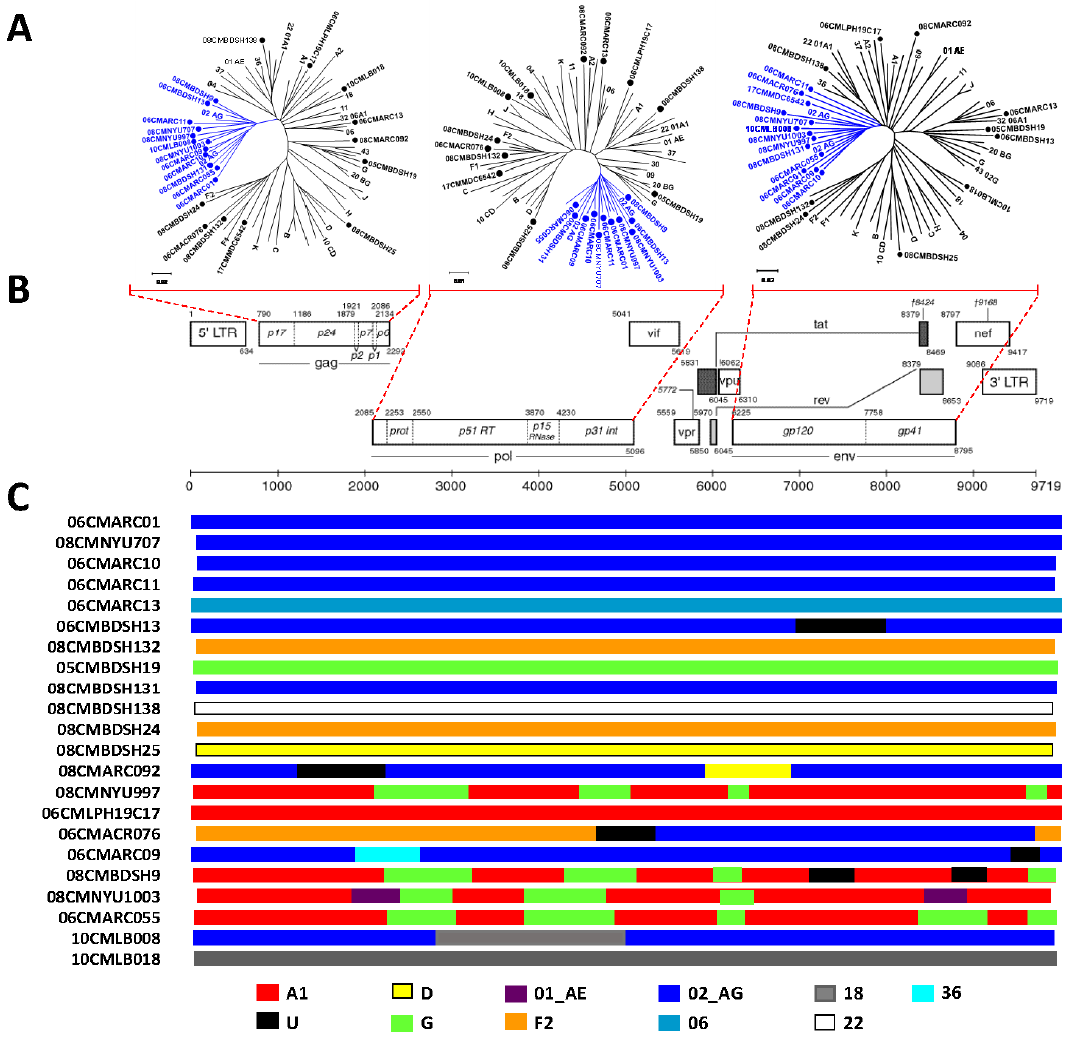
Figure 2. Diagram of the genomic structure of near full-length genome and subtype of gag, pol, and env regions. ( A ) Phylogenetic trees of regions gag, pol, and env regions. The trees correspond to genome segments in gag (HXB2 positions 790–2292), pol (HXB2 positions 2085–5096), and env region (HXB2 positions 6225–8795). References for the subtypes, sub- subtypes, and CRFs are listed in methods and materials and shown as black. The new identified sequences are indicated as dots “ • ” and cluster of CRF02_AG are shown as blue in the tree. ( B ) Reference structure of the HIV-1 genome HXB2 (K03455). ( C ) Diagram of the mosaic composition. Breakpoint locations are based on the HXB2 number engine. Each of the resulting genome was analyzed by SimPolt, jpHMM, and Genotyping separately, recombinant structures of each strain were determined and colored according to